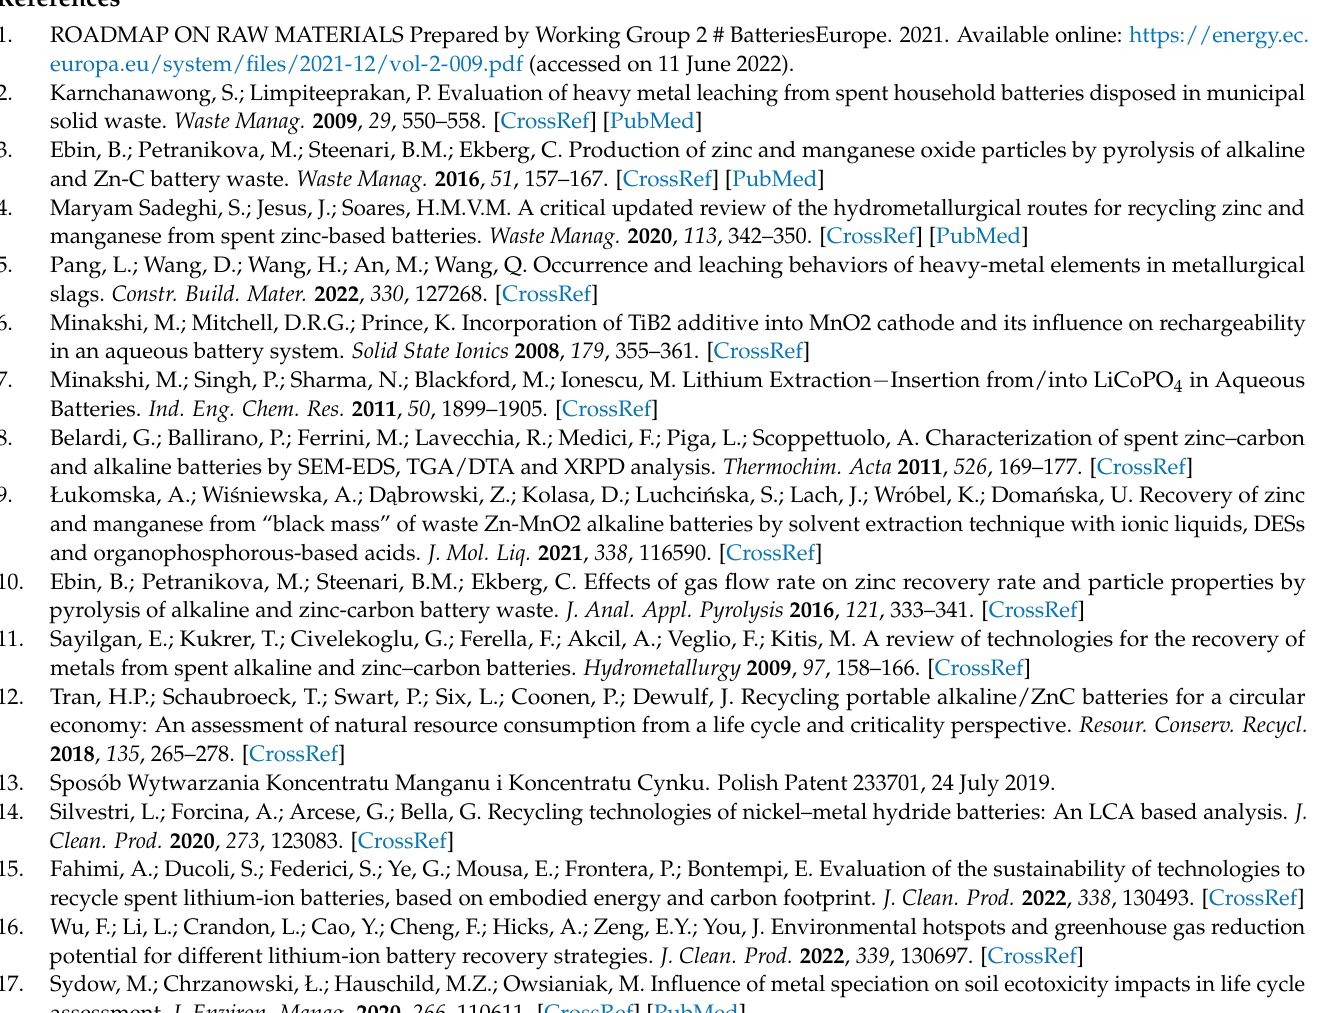
Figure S1: The contribution of the individual process to total impact scores as obtained for 18 different impact categories for Scenario 1; Figure S2: The contribution of various combined processes in total impact scores as obtained for 18 different impact categories for Scenario 2; Figure S3: Terrestrial ecotoxicity; Figure S4: Freshwater ecotoxicity; Figure S5: Marine ecotoxicity; Figure S6: Human carcinogenic toxicity; Figure S7: Human non-carcinogenic